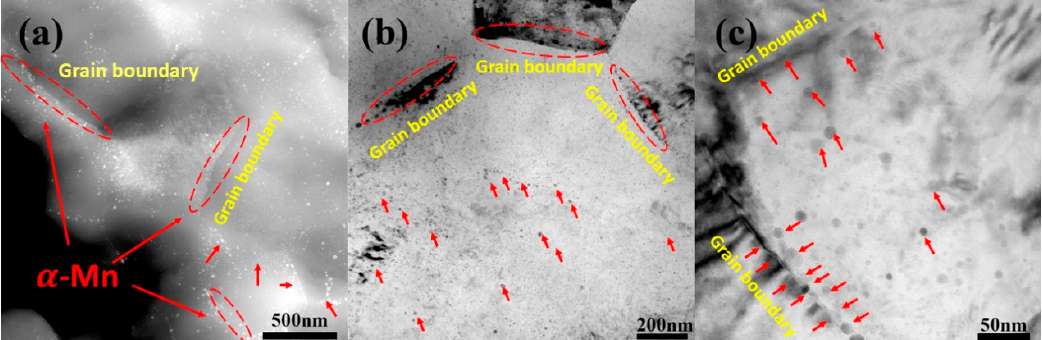
Figure 9. ( a ) S-TEM image of Mg-2 wt.% Mn-0.5 wt.% Sr alloy; ( b ) and ( c ) Bright field TEM images of Mg-2 wt.% Mn-0.5 wt.% Sr alloy. α -Mn are marked by red arrows and ellipses, and the Grain boundary are marked by yellow font. ( c ) is a partial enlarged view of ( b ), representing a complete grain.